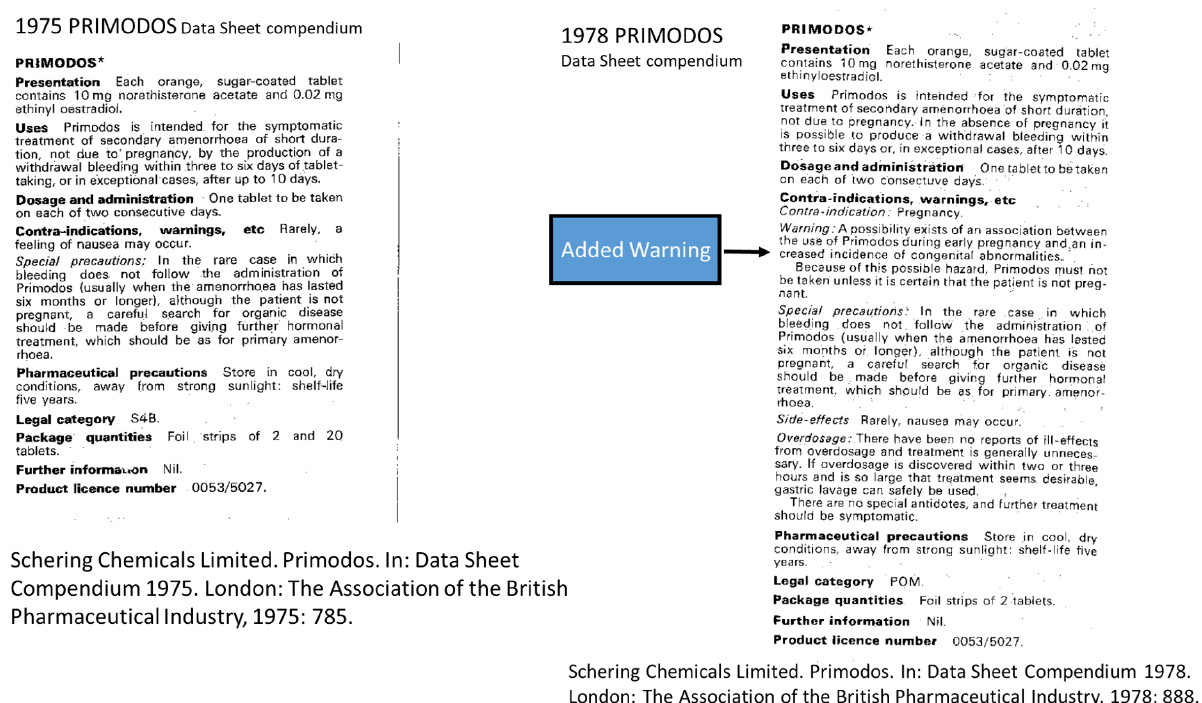
Figure 9. Primodos label 1975 and